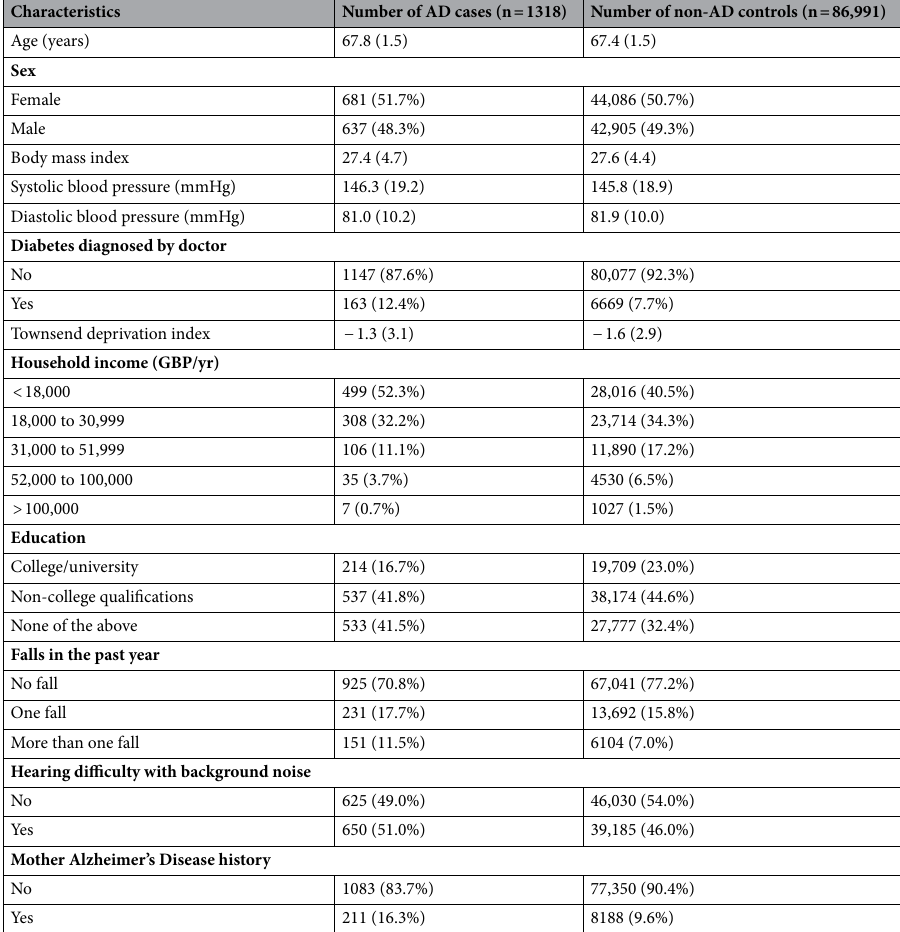
Table 2. Comparison of subject characteristics between AD cases and non-AD controls (age 65 +). For continuous data, mean and standard deviation (sd) for each group were shown. Missing data percentage: